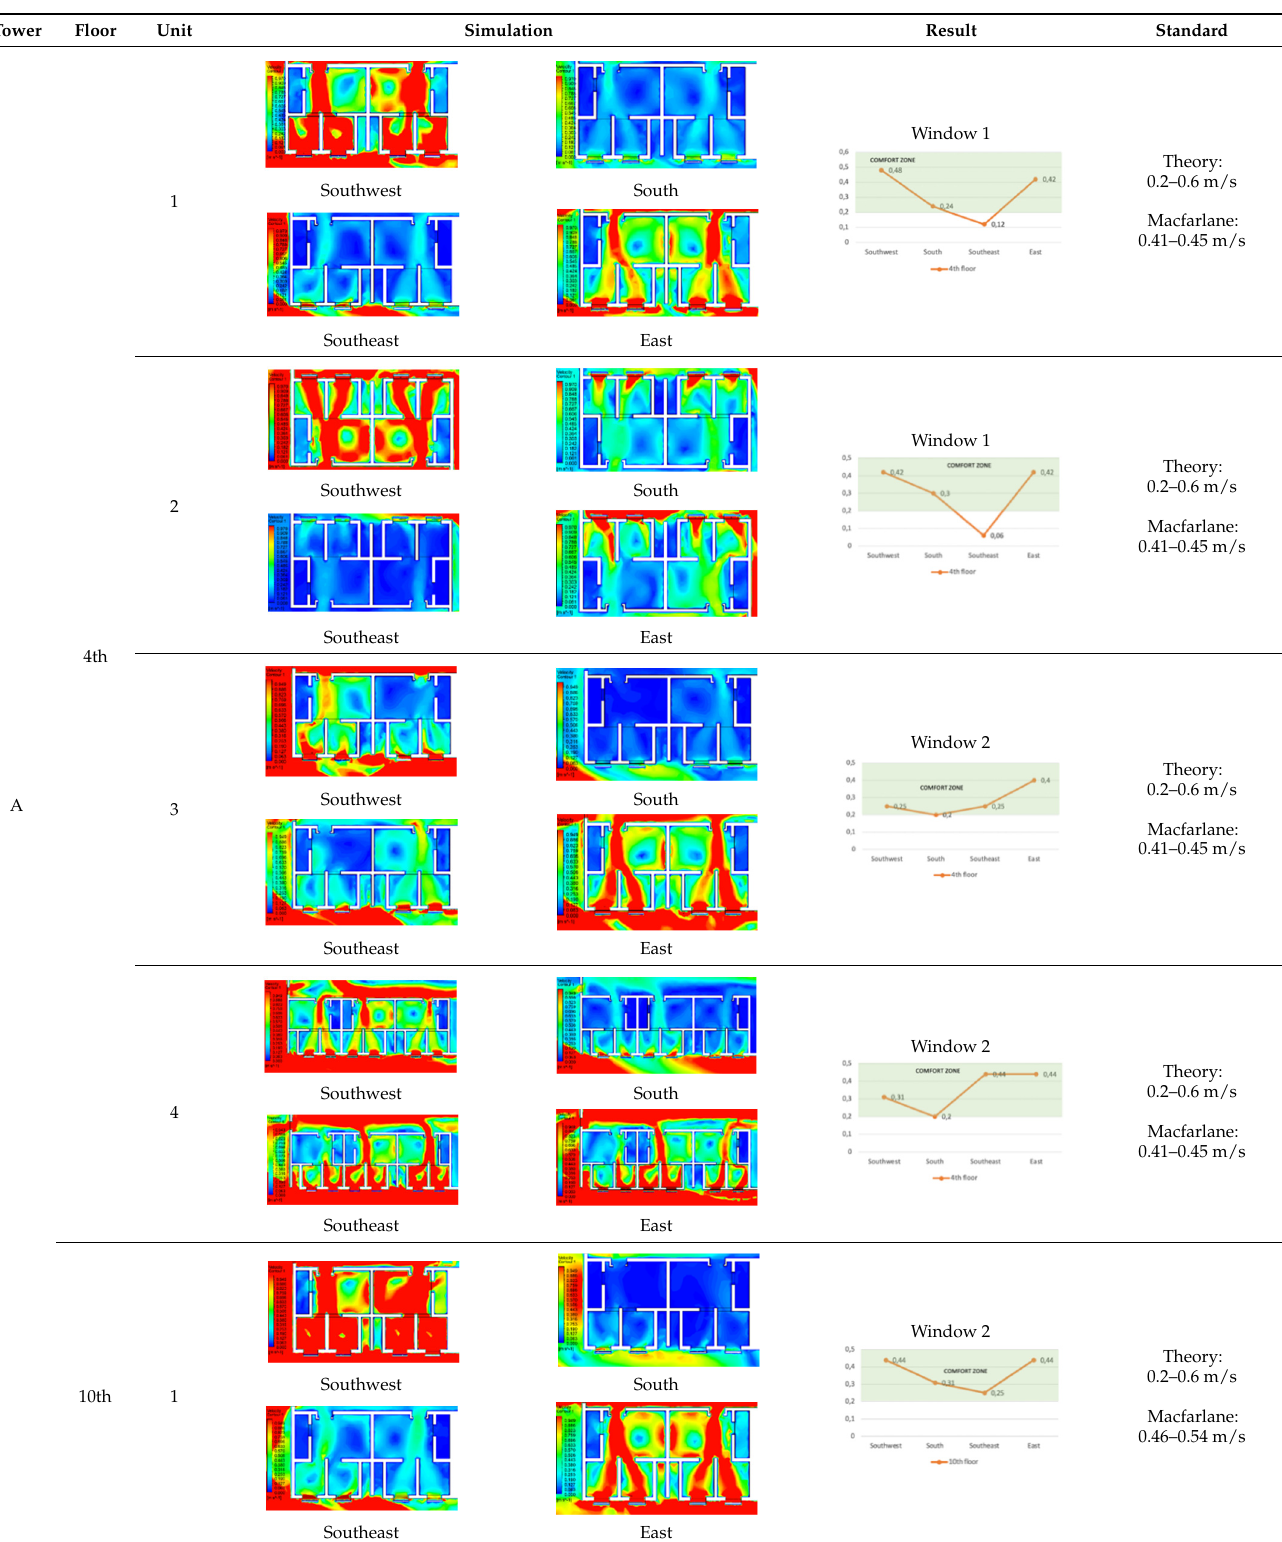
Table 11. CFD simulation results.